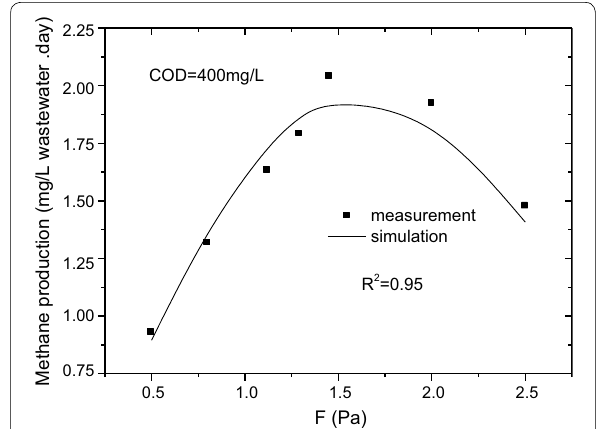
0.5 400 mg/L. Fig. 10 Methane production vs wall-shear stress, COD 200 mg/L. = = In order to validate the model, the measured data was used when COD was 200 mg/L. The fitting results were showed. Results showed the model’s predictions, agreed with the measurements well, the dif- ference between measurement and simulation was found in the rage of 1.5–13.0%. In this model, substrate concentration and pipe size were not considered that leaded to some errors between measure- ment and simulation. And it would be revised in our future